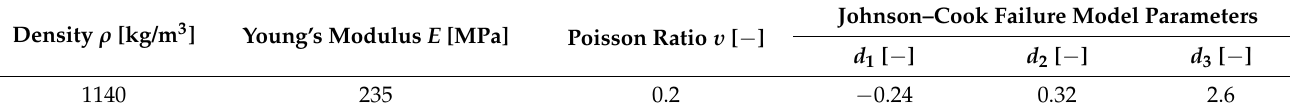
Figure 9. The construction of the FEM model in Abaqus using CEL method.